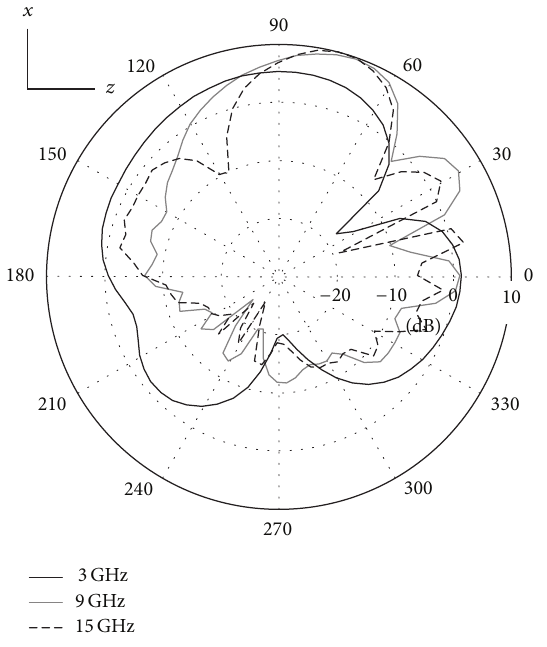
Figure 13: Radiation pattern of a conical antenna with elliptical aperture and reflector in the xz plane.